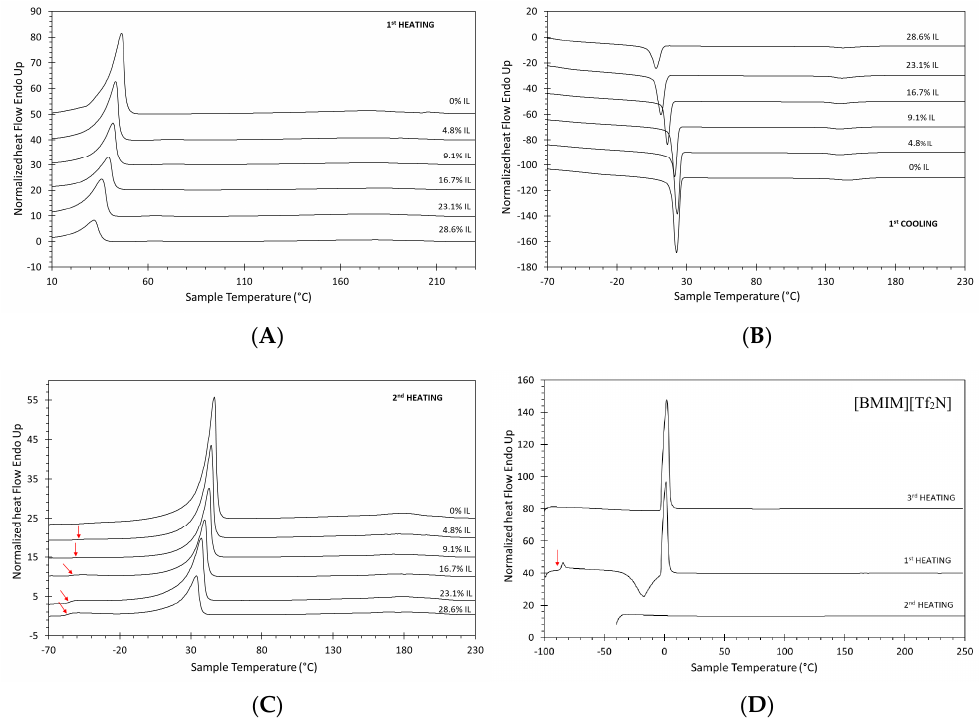
Figure 3. Example of DSC curves of sample P4 as a function of the ionic liquid (IL) content (in wt.%) at a heating and cooling rate of 15 °C min − 1 . ( A ) First heating run, ( B ) cooling run, ( C ) second heating run. ( D ) DSC curves of the pure ionic liquid [BMIM][Tf 2 N] obtained after different cooling procedures. The curves are shifted vertically for clarity and the Tg is indicated with a red arrow. Program of the analysis of the pure ionic liquid: First heating after normal cooling to − 100 °C, second heating after cooling to − 40 °C and annealing for 20 min; and third heating after normal cooling to − 100°C, heating to − 10 °C, annealing for 10 min, followed by a second cooling to − 100 °C (see the full temperature program of the IL in Table S1).